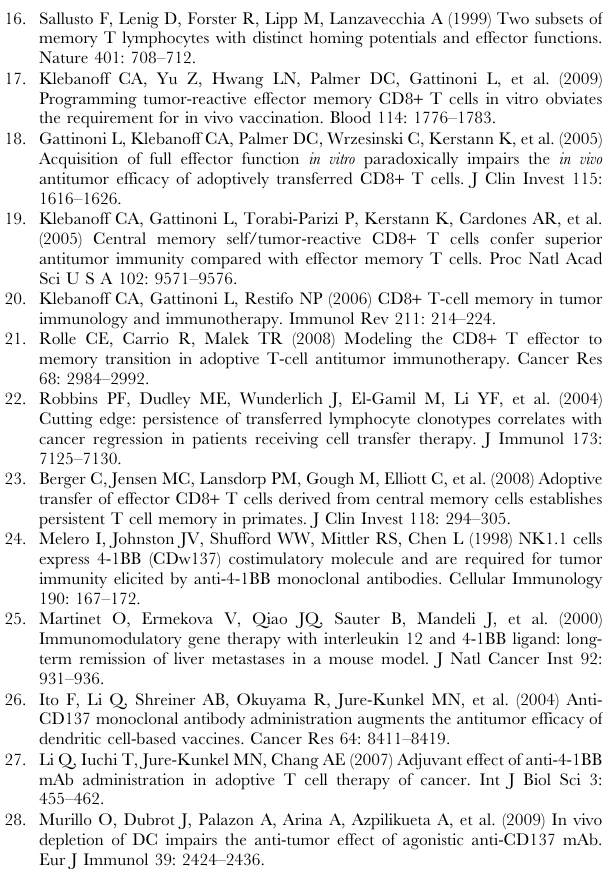
Figure S2 Lack of control of E.G7 tumor following anti-4-1BB treatment in 4-1BB-deficient mice. 4-1BB-/- mice were inoculated with E.G7 tumor cells on day 0, followed by two injections of anti- 4-1BB or rat IgG on day 8 and 11. Average tumor growth and survival curves are shown on the left and right panel, respectively. Data represent one experiment with 6 mice per